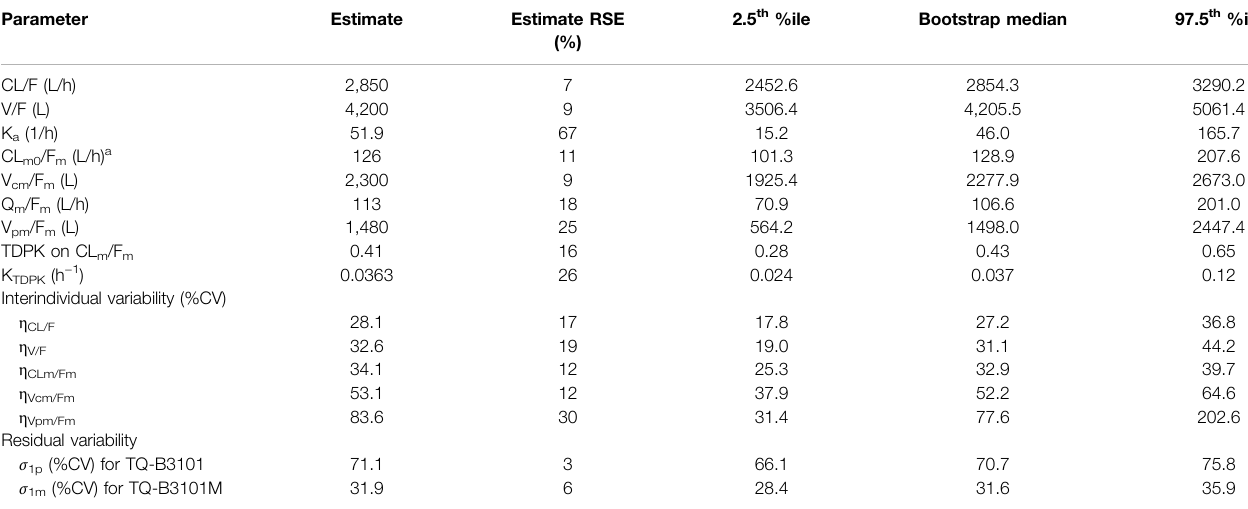
TABLE 3 | Parameter estimates of the fi nal oral PK model of TQ-B3101 in adult and adolescent patients. Parameter